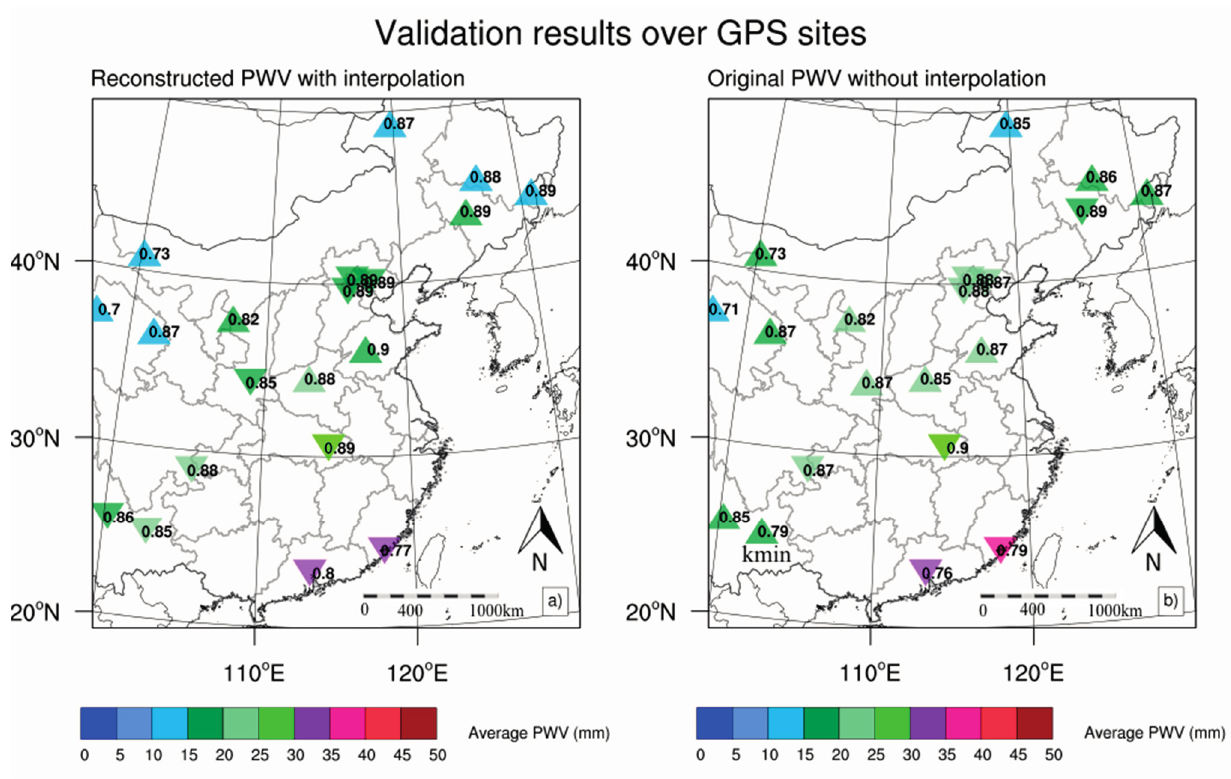
Figure 6. GPS validation results over sites: ( a ) validation with reconstructed PWV; ( b ) validation with original PWV. Upward and downward triangles represent positive and negative biases, respectively. Color represents the value of the annual average MTSAT PWV over each site. Numbers represent the correlation coefficients between MTSAT and GPS PWV